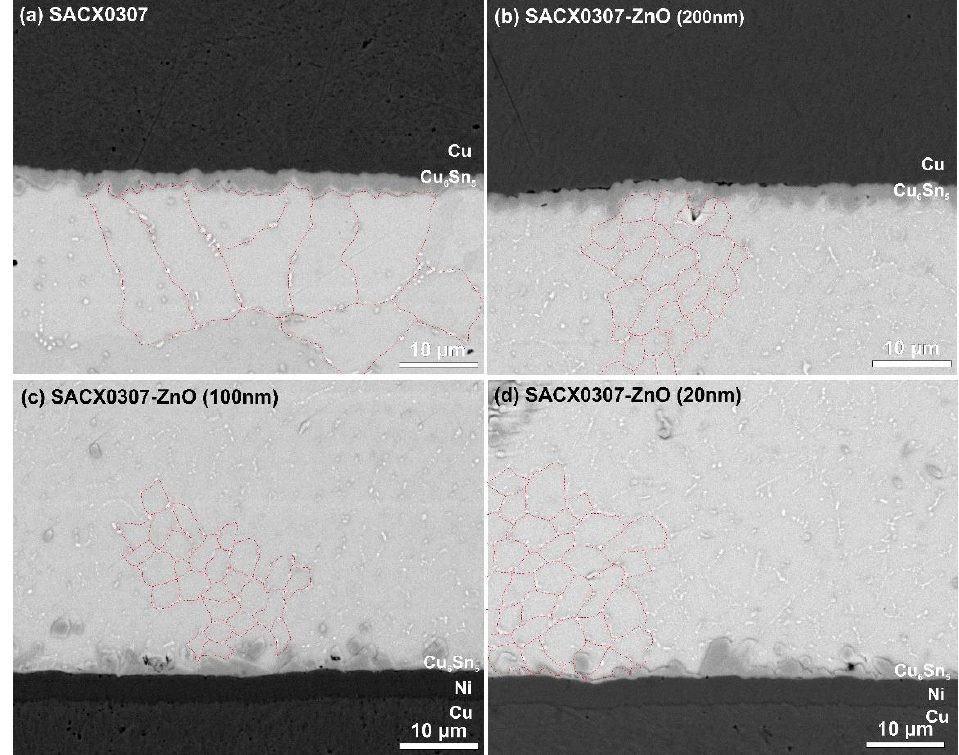
Figure 9. Sn grain and IMC layer structure of the different solder joints: ( a ) SACX0307; ( b ) SACX0307-ZnO-(200 nm); ( c ) SACX0307-ZnO-(100 nm); ( d ) SACX0307-ZnO-(50 nm). This shows that ZnO nanoparticles have an increased ability to limit grain growth during solid-state cooling [27]. A possible explanation for the grain refinement is the sur- face adsorption theory. The ZnO particles—incorporated into solder—cannot wet the β– Sn matrix during the solidification process. They do not form IMCs in the solder matrix, and they are noncoarsening and nonreacting. The refinement of the microstructure is caused by high surface free energy on the solidified grain surfaces through the matrix, which adsorbs the ZnO nanoparticles during the solidification process [37]. No significant differences were found in Sn grain refinement between the upper and lower parts of the solder joint (Figure 8). This means that the distribution of the ZnO particles was most likely uniform in the solder joints. In the IMC layers, the results differed significantly at the upper and lower regions of the solder joints. The addition of ZnO did not have any effect on the upper IMC layer growth. The average thicknesses were around 2 µm in all cases (Figure 9a,b). However, the growth of the lower IMC layer was significantly suppressed by the ZnO nanoparticles. They decreased the thickness to 1.1–1.4 µm. Some differences were found between the composite solder alloys. The largest (200 nm) ZnO nanoparticles provided the thinnest IMC layers. Because the distribution of the ZnO particles was uniform in the solder joints (according to the Sn grain refinement), the different growth of the IMC layer at the lower and upper part of the solder joints can be explained by other effects. The reason might be that the solder pads at the diodes did not contain the Ni barrier layer (opposite to the substrate). The Ni barrier layer decreases the Cu diffusion towards the solder joints. At the upper part of the solder joints, the ZnO ceramic could not have such a significant effect on the growth of the IMC layer than at the bottom part. At the upper part, there was no Ni barrier layer that could block the diffusion of Cu atoms from the solder pad. The typical structure of the lower IMC layer in the different solder joints can be seen in Figure 10. The suppression effect of the ZnO (200 nm) particles on the growth of the IMC layer is the most visible (Figure 10a,b). The ZnO particles (with a size of 200 and 100